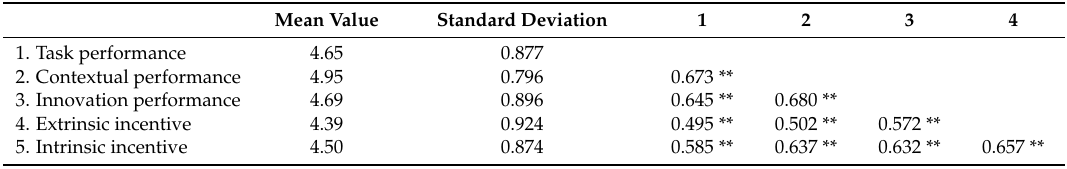
Table 2. Descriptive statistics of variables and the correlation